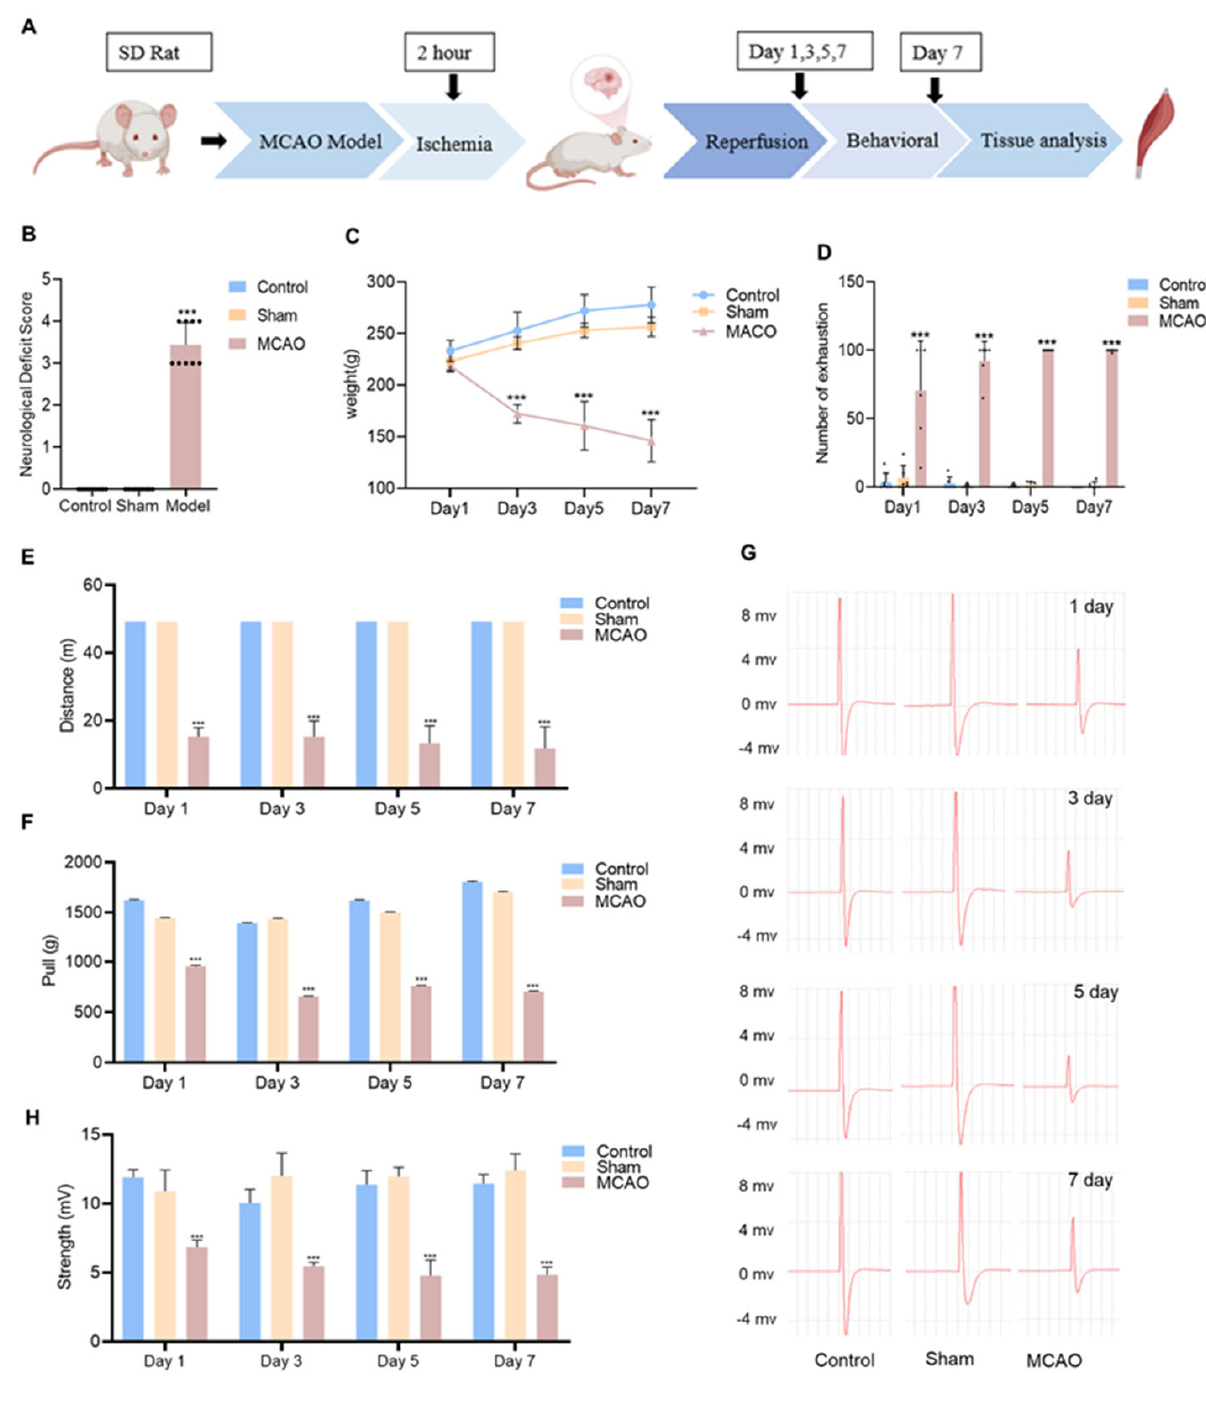
Figure 1. Behavioral changes in MCAO rats. ( A ) Behavioral experimental design for studying changes in muscle function after middle cerebral artery occlusion (MCAO) model rats. ( B ) Assessment of neurological deficits in Zea-longa rats ( n = 9). ( C ) Body weight change of rats ( n = 9). ( D ) The number of 5 min of force exhaustion collected by the small animal treadmill ( n = 9). ( E ) 5 min running distance ( n = 9). ( F ) Grip strength in rats ( n = 9). ( G ) Muscle electrical signal intensity ( n = 8). ( H ) Visual diagram of muscle electrical signal intensity. *** p < 0.001 vs. the control group, no significant difference between the control group and